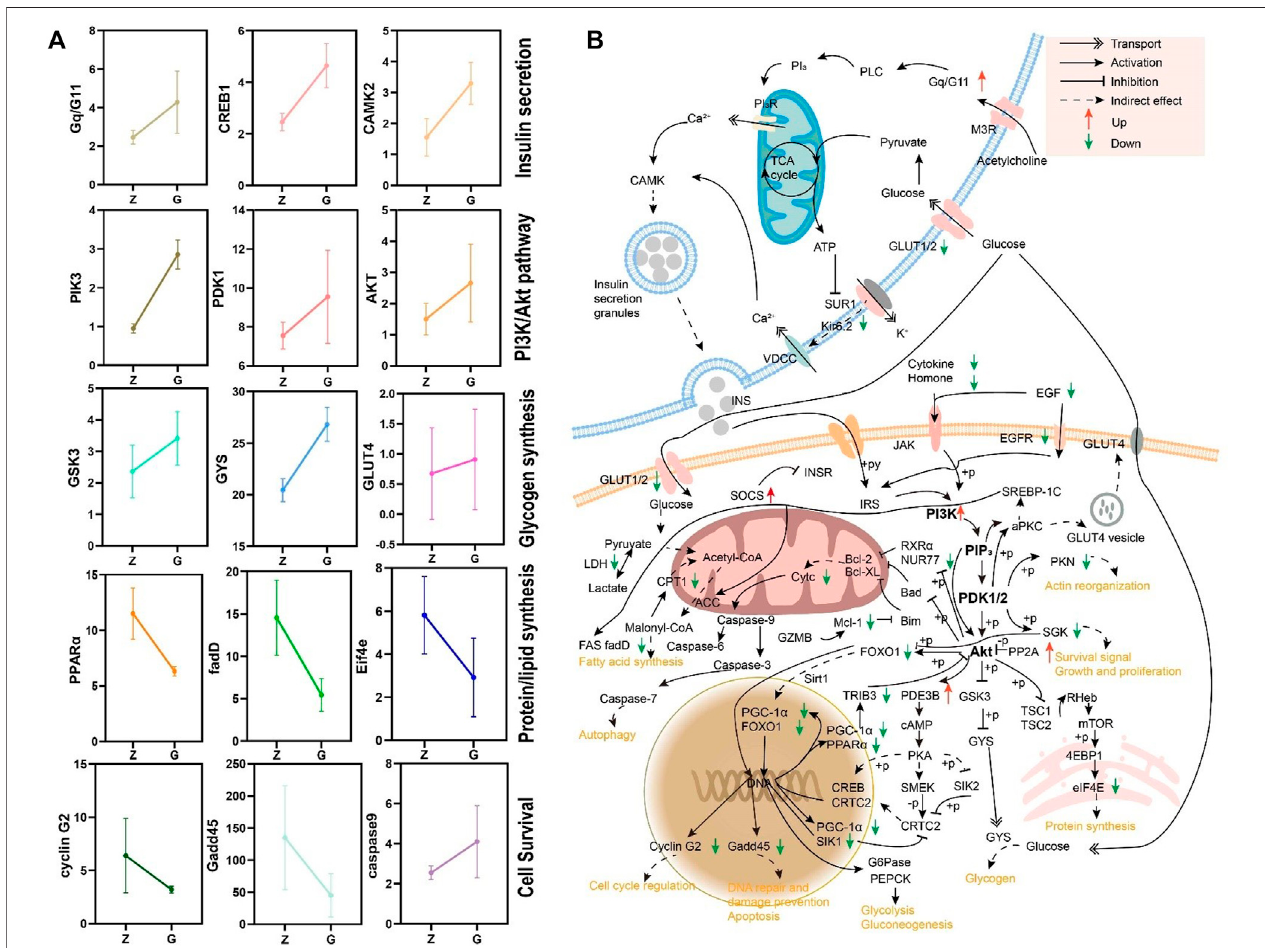
FIGURE8|(A) ExpressionpatternsofgenesintheKEGGenrichedpathway. (B) Aregulatorynetworkbasedontranscriptomicdataforhighstarchinjuryintheliver of largemouth bass.